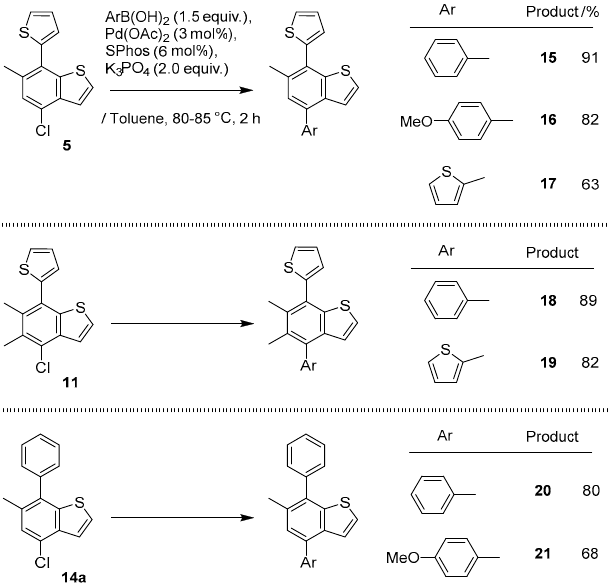
Figure 1. Suzuki–Miyaura cross-coupling of 4-chlorobenzothiophenes.